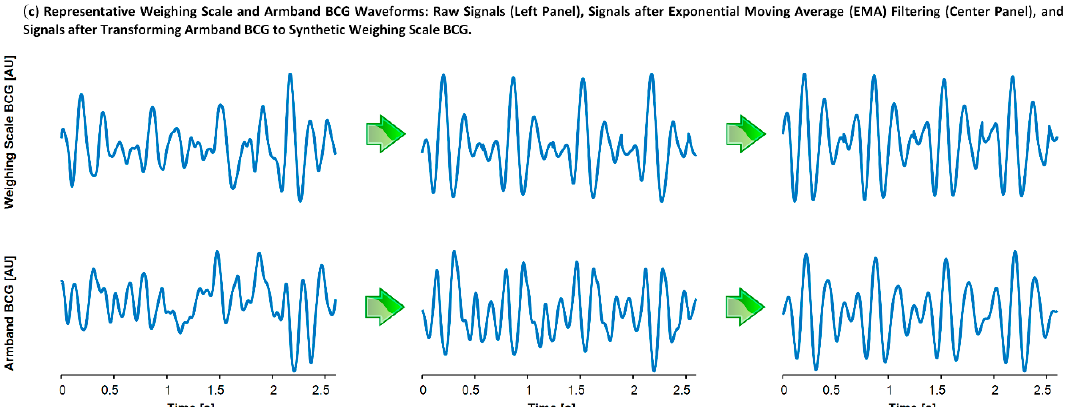
Figure 2. Procedure for signal pre-conditioning and transformation of armband BCG to weighing scale BCG. ( a ) Signal pre-conditioning procedure. LPF: low-pass filtering. BPF: band-pass filtering. EMA: exponential moving average. ( b ) Procedure for transforming armband BCG to weighing scale BCG. F 2 , F 3 , F C : frequencies associated with 2nd (F 2 ) and 3rd (F 3 ) spectral peaks and the band (marked as red vertical line in the armband BCG signal) of high-pass filtering (HPF). ( c ) Representative weighing scale and armband BCG waveforms: raw signals (left), signals after EMA filtering (center), and signals after transforming the armband BCG to the synthetic weighing scale BCG.